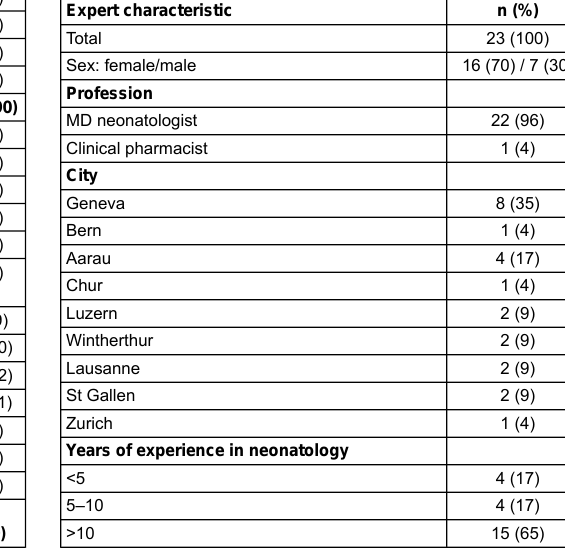
Table 4: Characteristics of participating Swiss